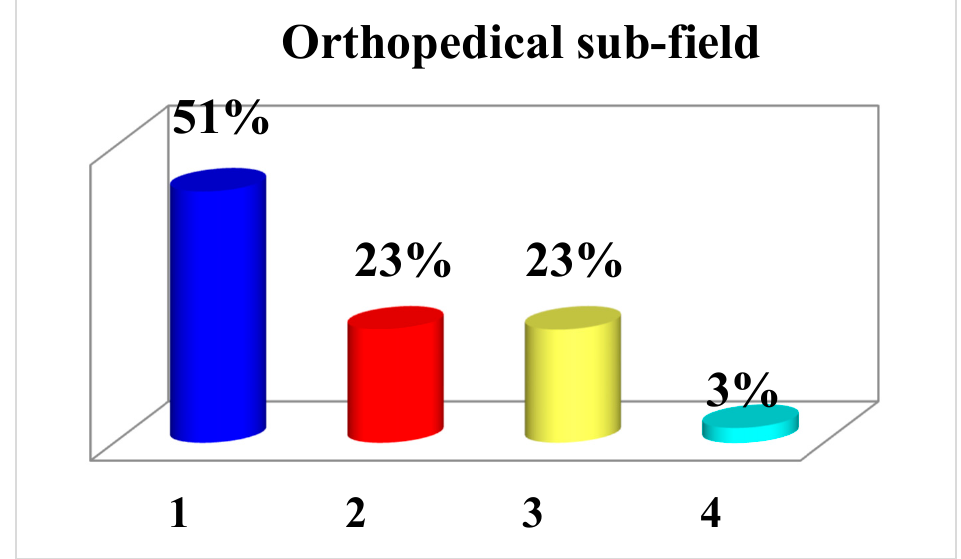
Figure 6. Graph showing the fields involved (orthopedics/traumatology) in the procedures under study. (1) Trauma; (2) election; (3) undetermined; (4) others.